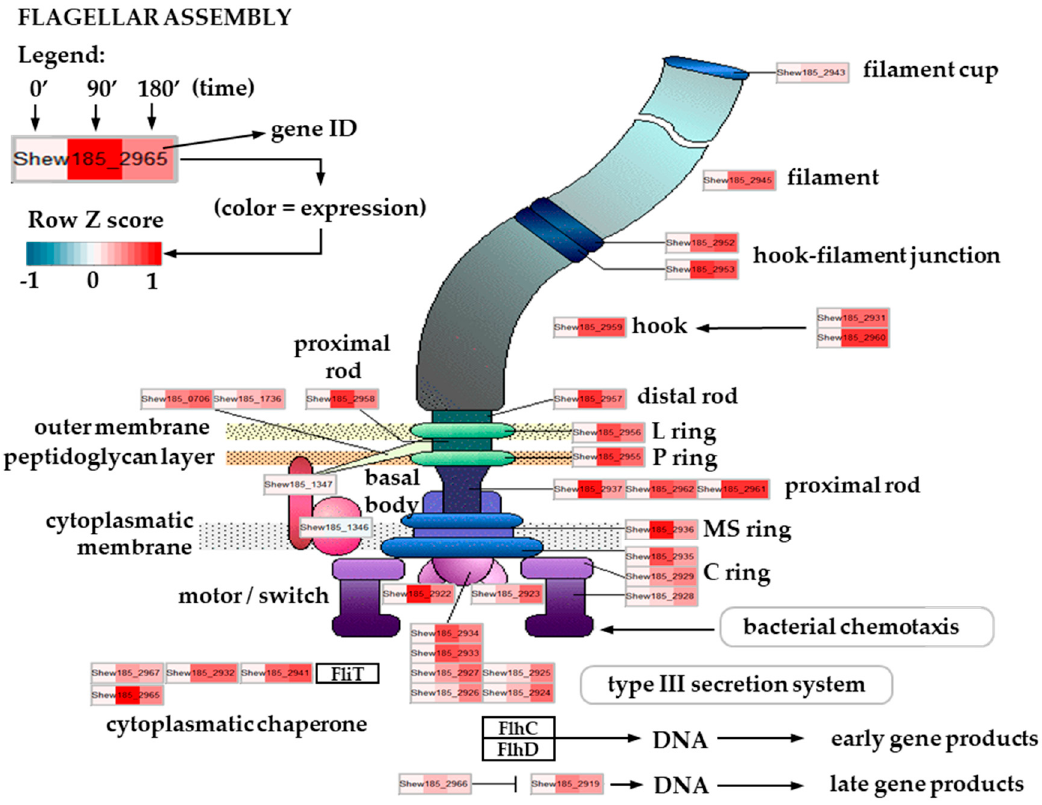
Figure 3. Expression changes in S. baltica flagellar assembly pathway upon cold stress. Scheme of flagellar assembly pathway (source: Kyoto Encyclopedia of Genes and Genomes (KEGG) database). Tripartite heatmap boxes show row Z-score scaled normalized expression values for corresponding genes upon cold stress at 0, 90 and 180 min time points, respectively.